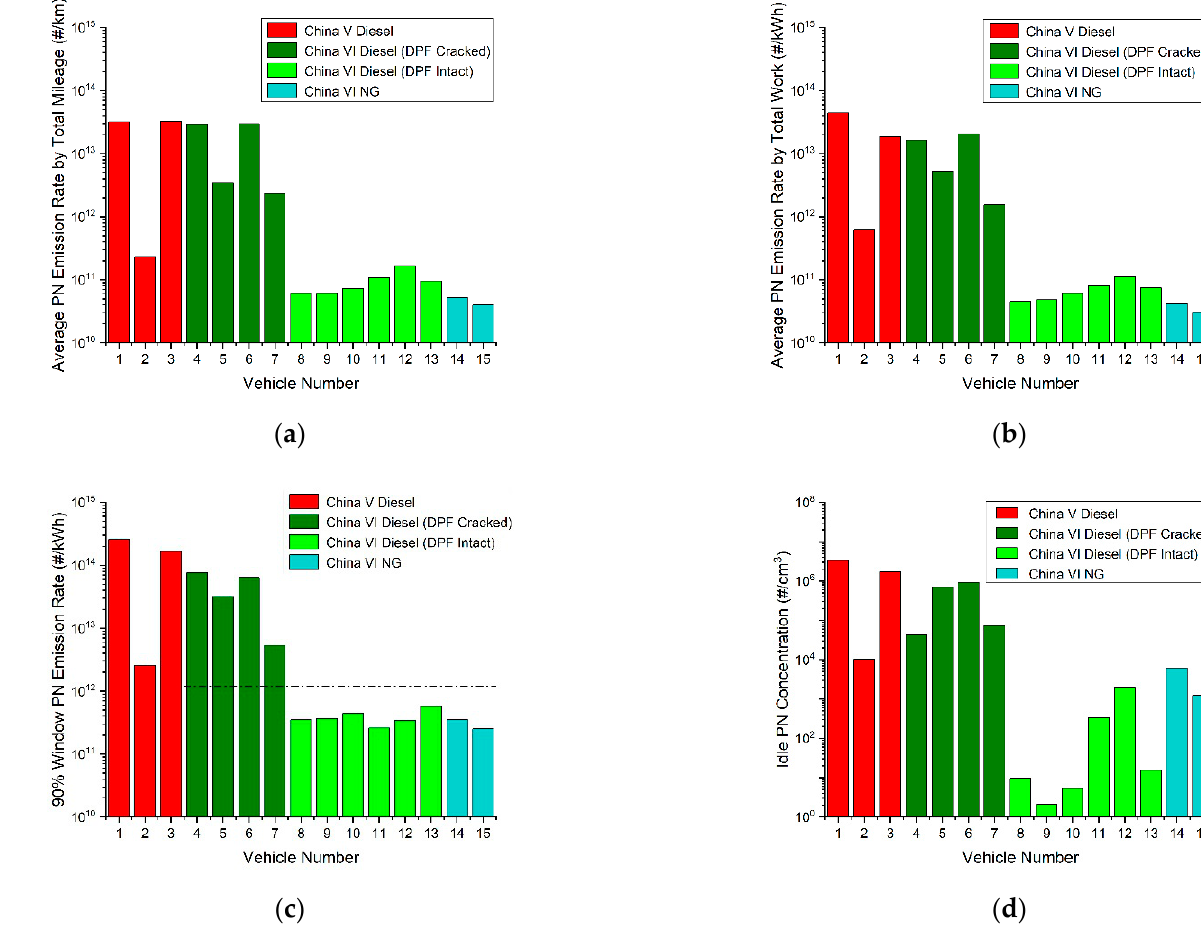
Figure 4. PN emission and idle PN concentration measured by PEMS test. ( a ) Average PN emission rate by total mileage; ( b ) Average PN emission rate by total work; ( c ) 90% window PN emission rate; ( d ) Average idle PN concentration.